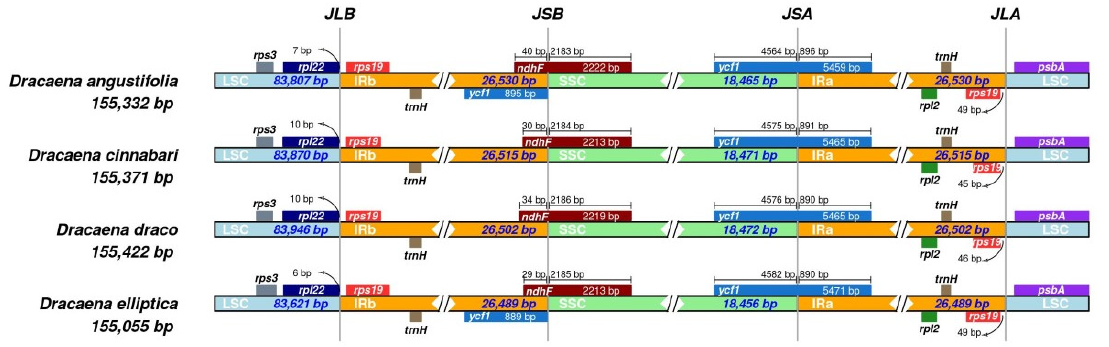
Figure 3. Comparison of the borders of LSC, SSC, and IR regions among the four Dracaena chloroplast genomes.